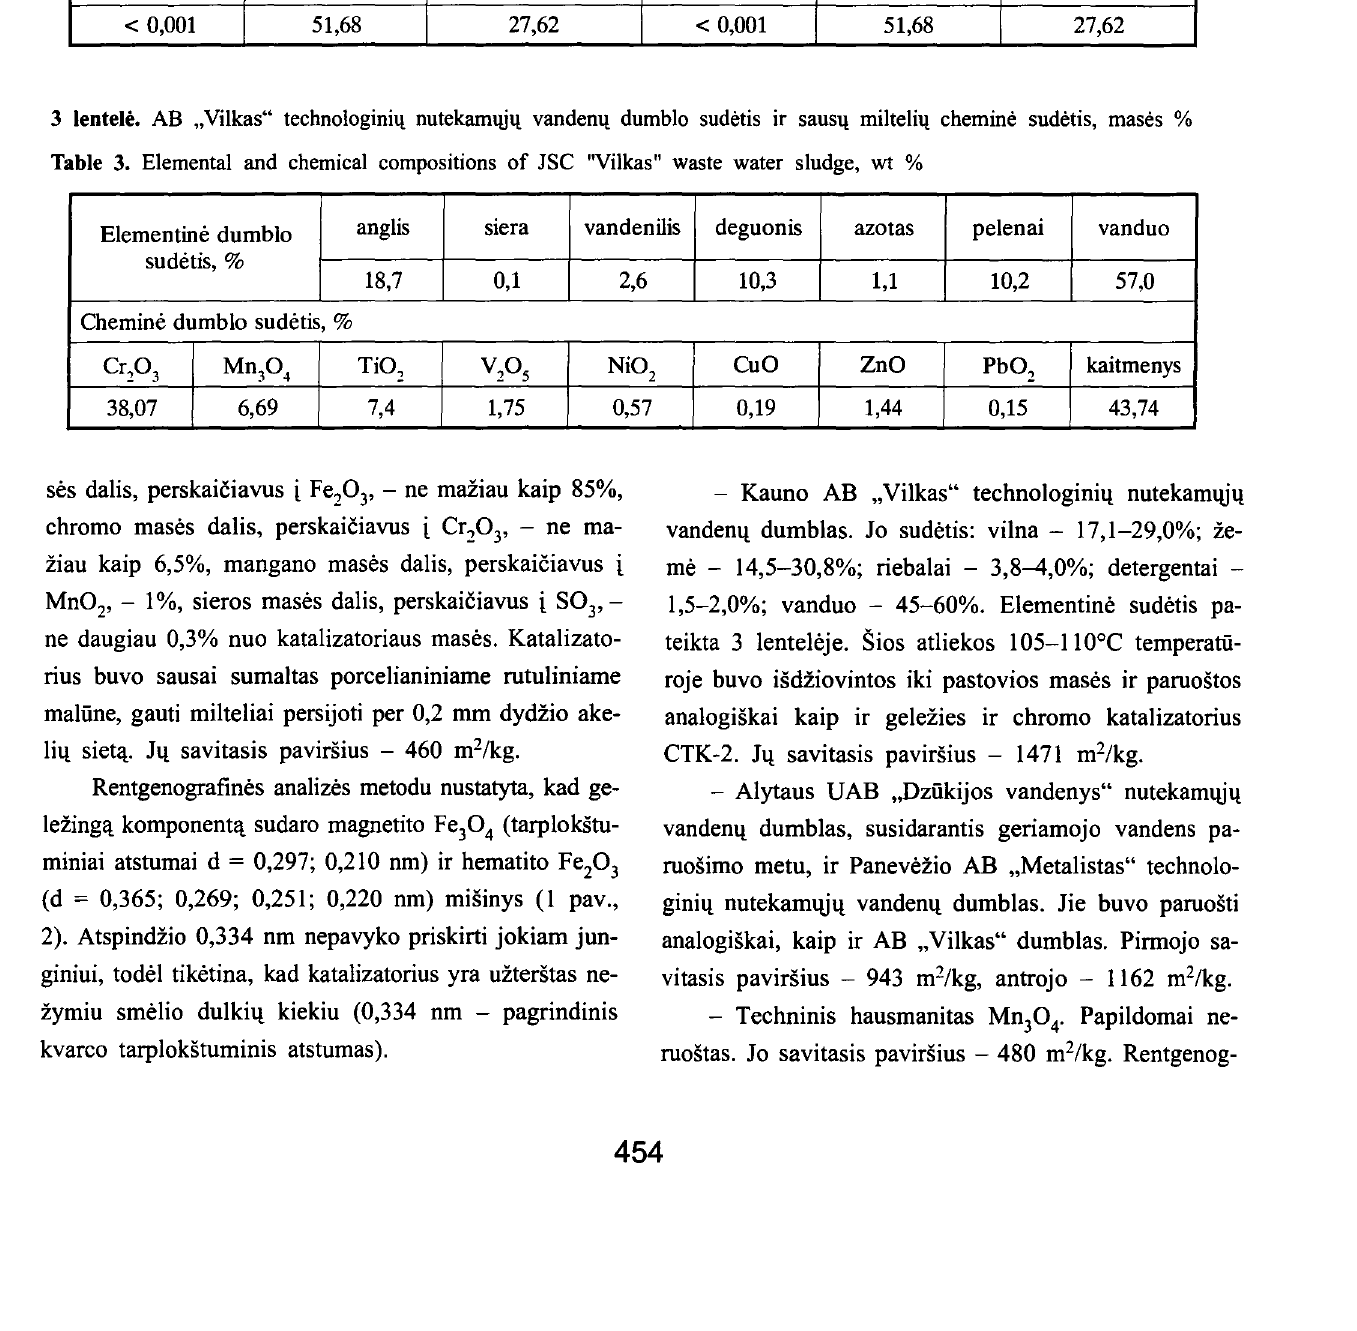
Table 2. Granulation composition of Kertupis and Dukstyna clay beds, wt % Daleliq Daleliq kiekis, % skersmuo, mm